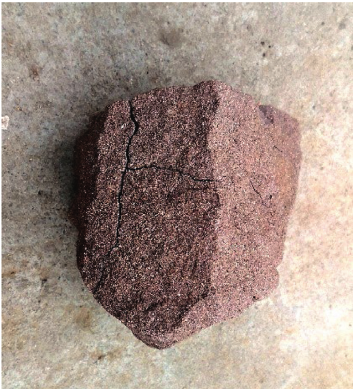
Figure 5: Cracks in the rock.